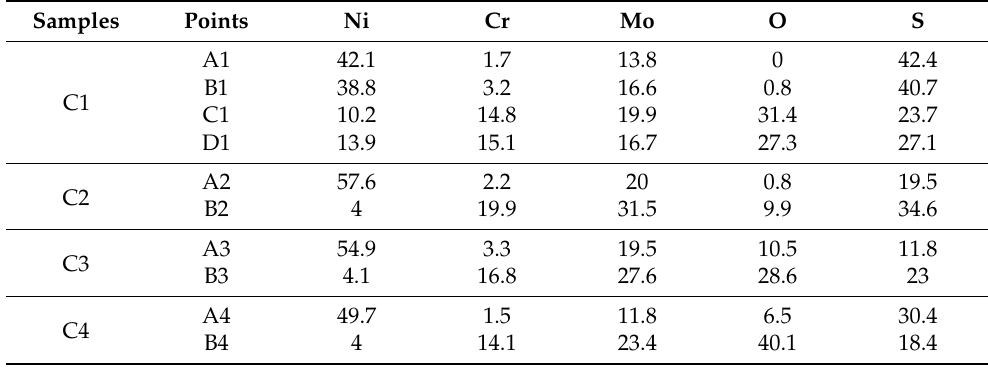
Table 4. EDS results (at.%) of typical points displayed in Figure 9.